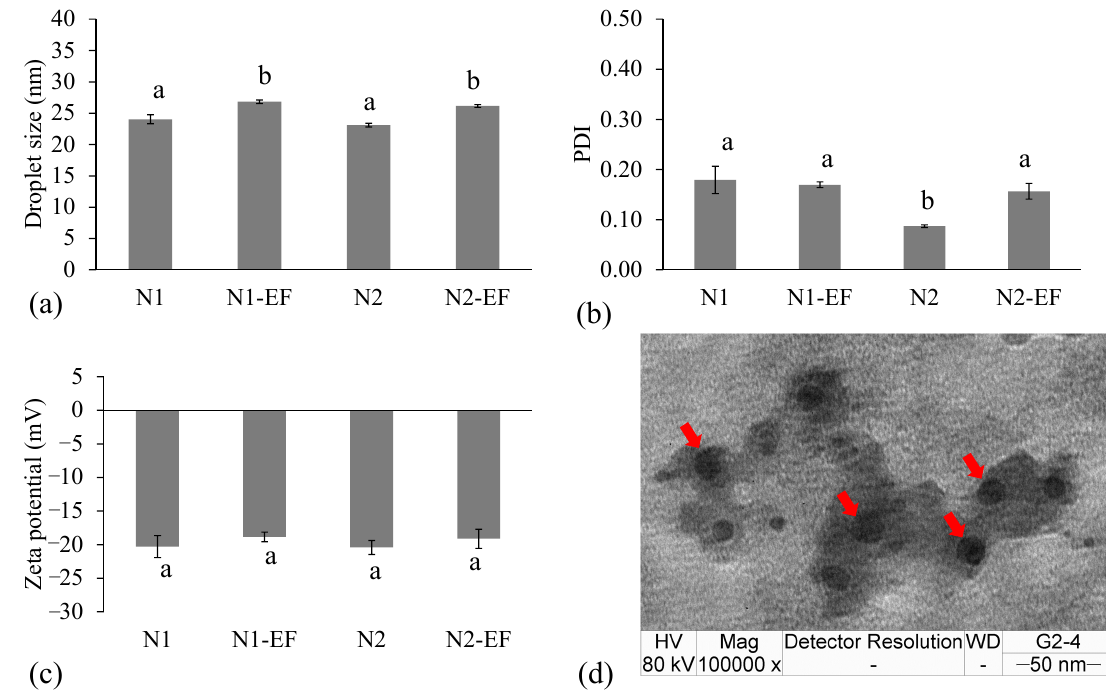
Figure 2. Mean droplet size ( a ), polydispersity index (PDI) ( b ) and zeta potential ( c ) of ethanolic fraction (EF)-encapsulated nanoemulsions (N1-EF and N2-EF) and their unloaded nanoemulsions (N1 and N2) produced by PIT method (mean ± SD; n = 3) together with ultrastructural image of EF-loaded nanoemulsions visualized through TEM ( d ). Di ff erent superscript letters ( a and b )